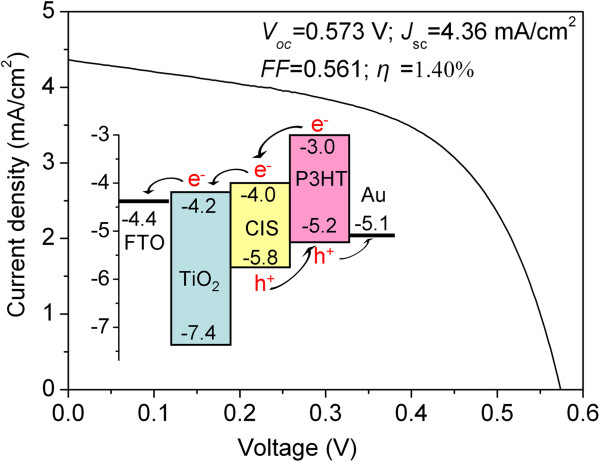
J-V characteristic curve of the HSC. The inset is band alignment among TiO2, CIS, and P3HT.